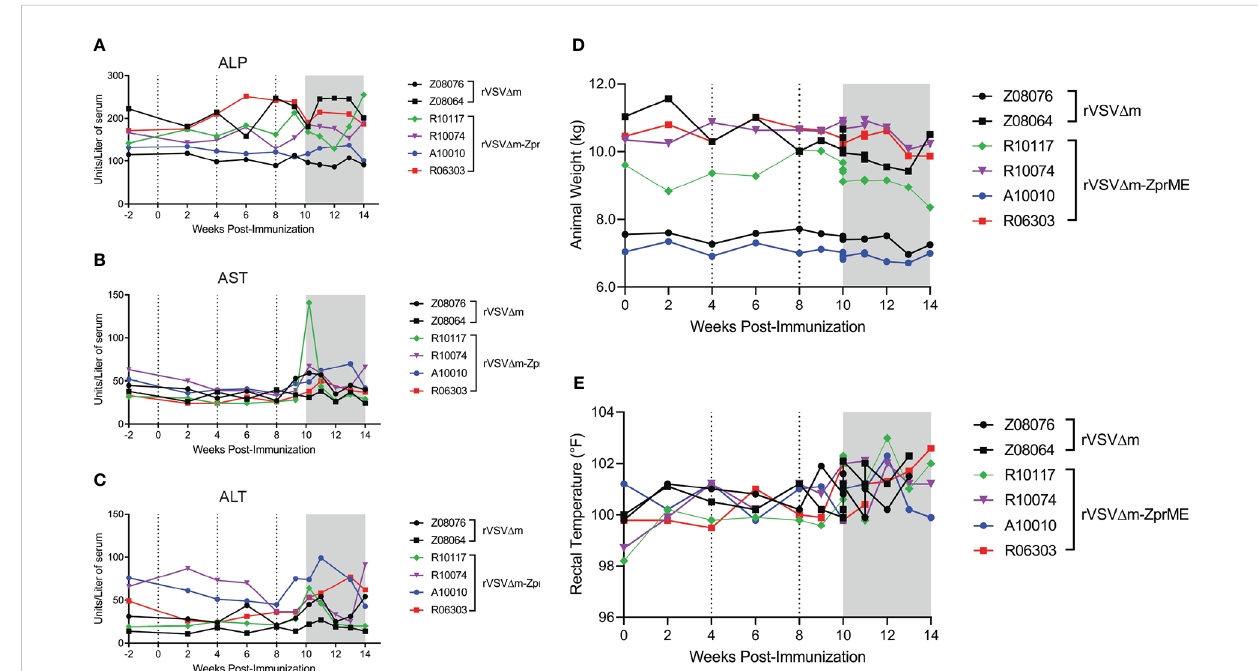
FIGURE 2 Clinical parameters of study animals and serum chemistry. Serum chemistry measurements for (A) alkaline phosphatase (ALP) (B) aspartate transaminase (AST) and (C) alanine transaminase (ALT) liver enzymes. Points on the plot represent individual animals for rVSV D M (black) and rVSV D M-ZprME (colored) vaccine regimens. (D) Animal weight (kg) and (E) body temperatures in Fahrenheit (°F) measured by rectal thermometer over the study period. (A – D) Dotted lines indicate immunizations and the ZIKV phase is the shaded grey